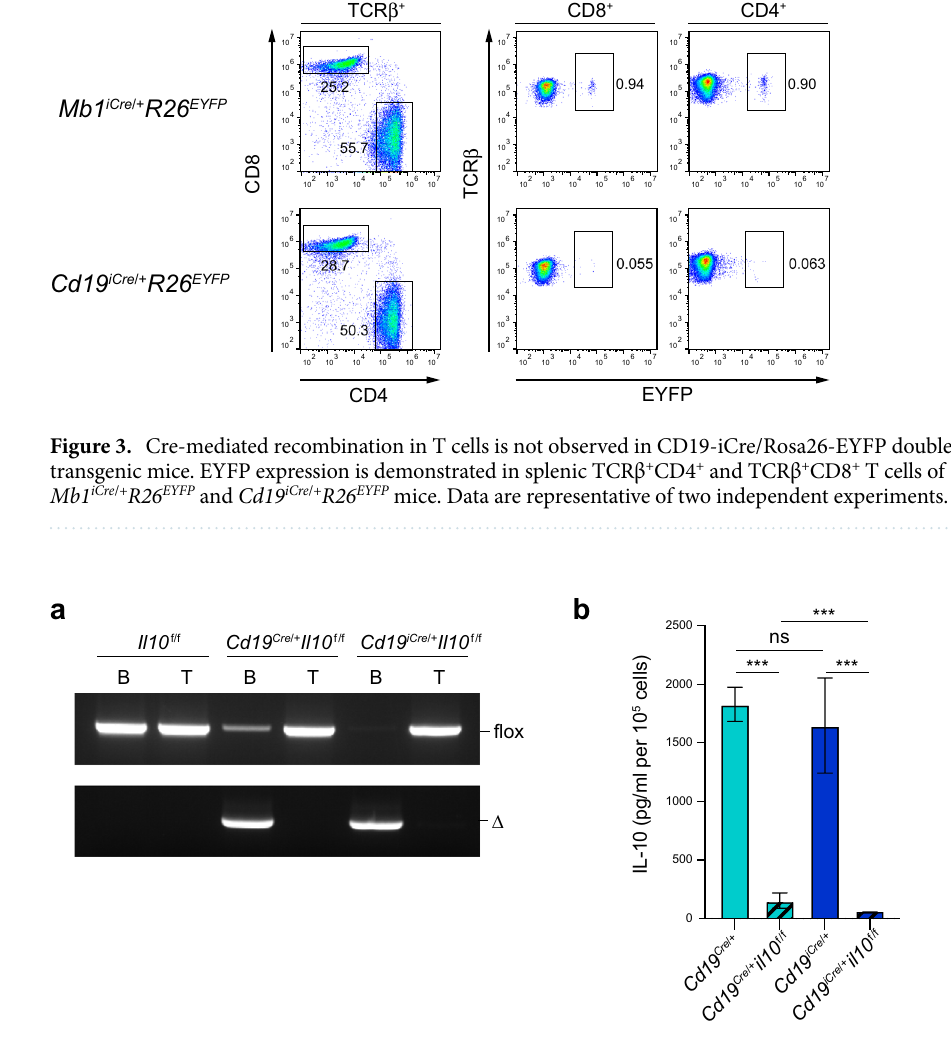
Figure 4. Efficient excitation of floxed allele in CD19-iCre mice. ( a ) Genomic PCR of B and T cells sorted from the spleen of Il10 f/f , Cd19 Cre /+ Il10 f/f , and Cd19 iCre /+ Il10 f/f mice. Amplicons are identified as floxed (flox) and Delta (Δ) alleles. ( b ) ELISA of IL-10 by B cells isolated from Cd19 Cre /+ , Cd19 Cre /+ Il10 f/f , Cd19 iCre /+ , and Cd19 iCre /+ Il10 f/f mice and cultured with LPS for 48 h followed by stimulation with anti-IgM for 24 h. Data are representative of at least three independent experiments ( a ), or pooled from three independent experiments ( b ). Data are presented as mean ± SD. * P < 0.05; ** P < 0.01; *** P < 0.001; **** P < 0.0001; ns, not significant. The P values were obtained by Mann–Whitney U test ( b